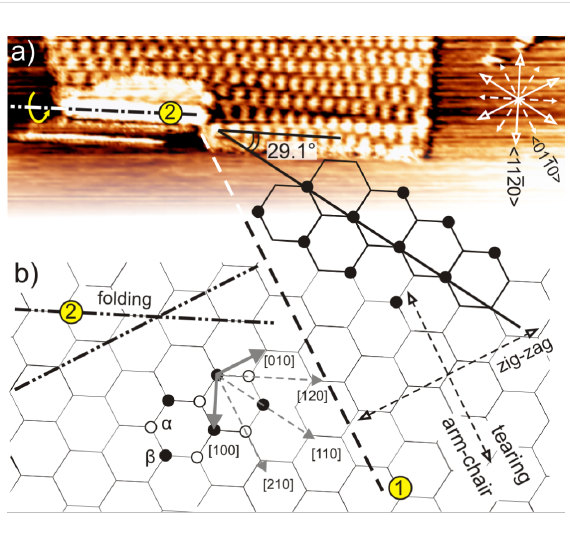
Figure 2: (a) Cut-out portion of the STM image showing the final superlattice with [210] tearing direction numbered as (1) and the [120] folding axis numbered as (2). (b) graphite lattice of the top layer with tearing direction and folding axis marked in accordance with (a). Short grey arrows represent the graphite unit vectors. The graphite lattice is not drawn to scale to that of the STM image.